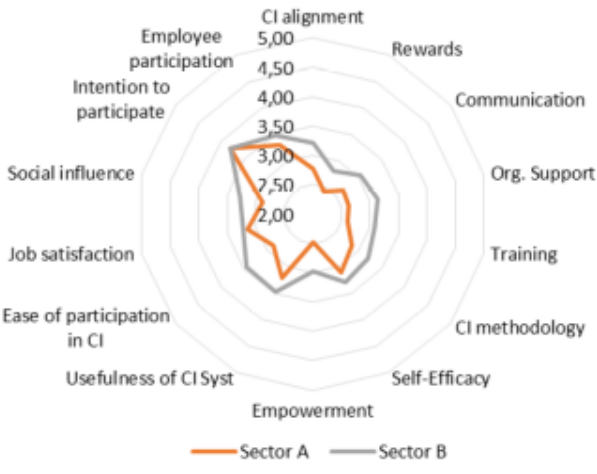
Figure 5. Industrial case: comparison between